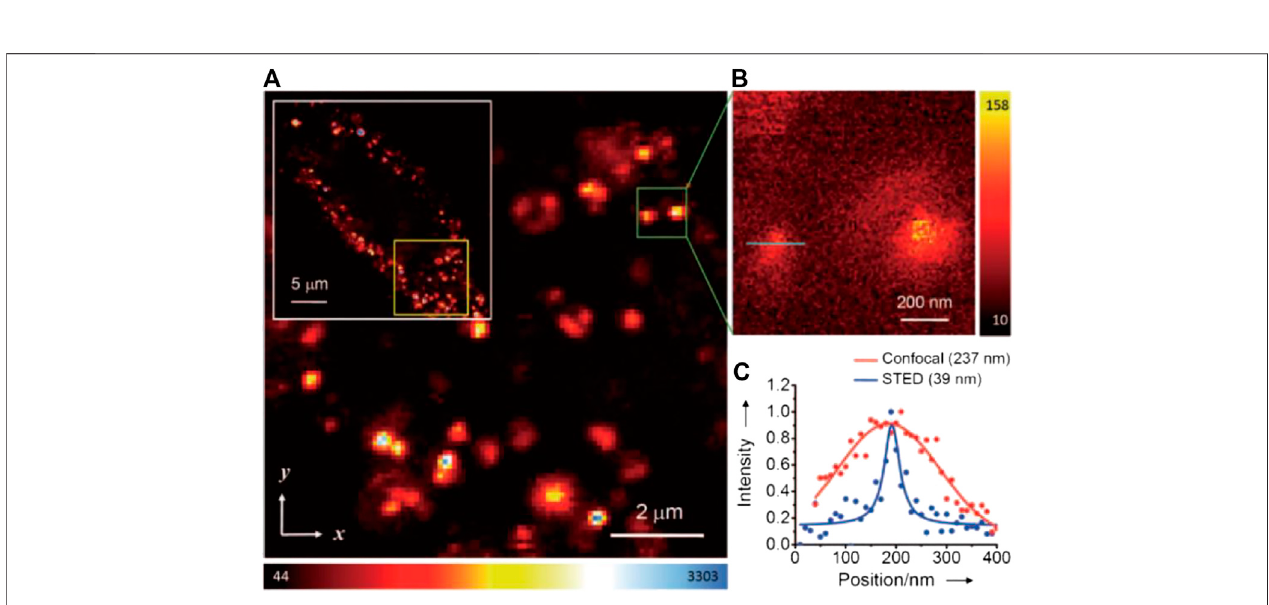
FIGURE 6 | Confocal and STED imaging of HeLa cells labeled with BSA-conjugated FNDs by endocytosis (Tzeng et al., 2011). (A) Confocal image of HeLa cells labeled with FNDs. (B) STED image of single FNDs. (C) Plot fi le for confocal and STED imaging results in the region of interest (green line in B ).